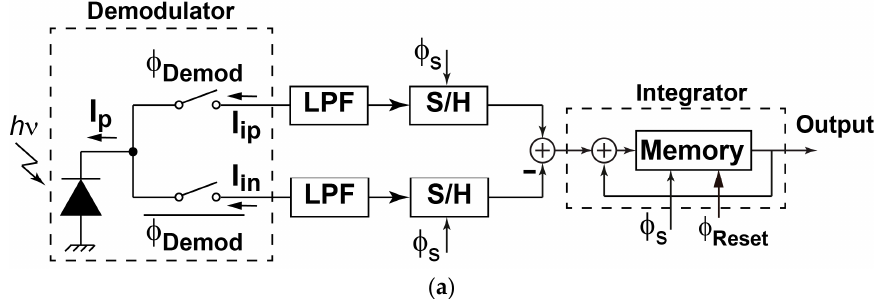
Figure 4. Cont. Figure 4. Cont.